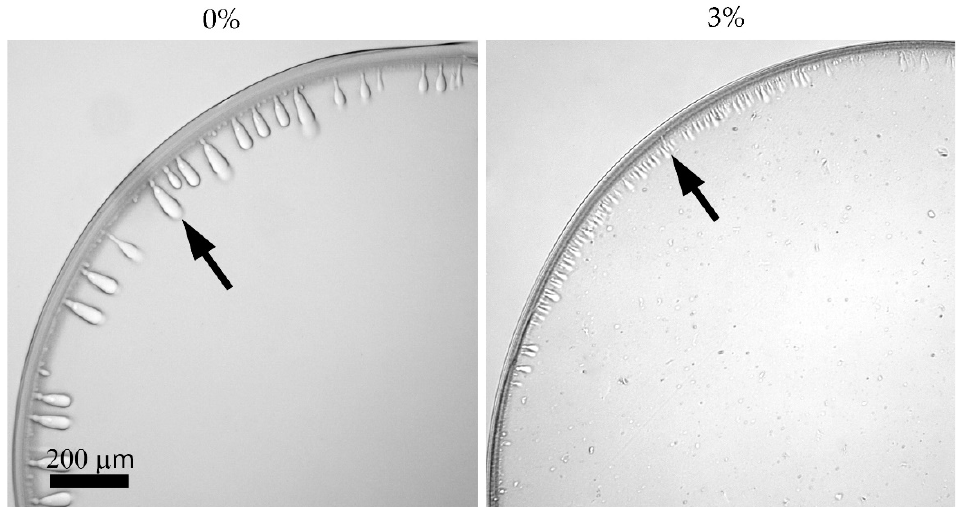
Figure 12. Optical microscopy images of droplets after the coagulation of a 20 wt% PAN solution with and without silica. Silica concentration is at the solution weight.